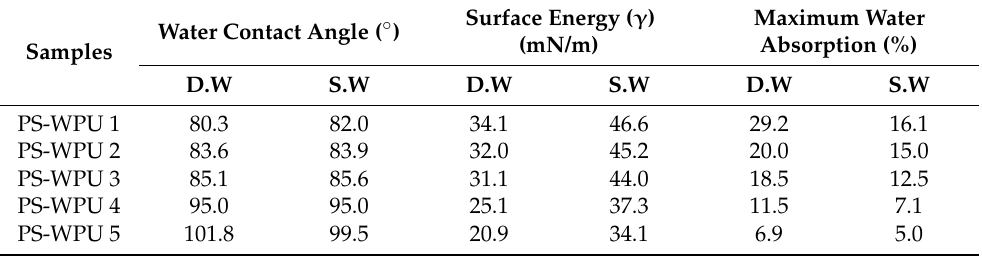
Figure 8. Water contact angles images of the recorded droplets (D.W and S.W) on the surface of PS-WPUs. Table 6. Performance of the PS-WPU